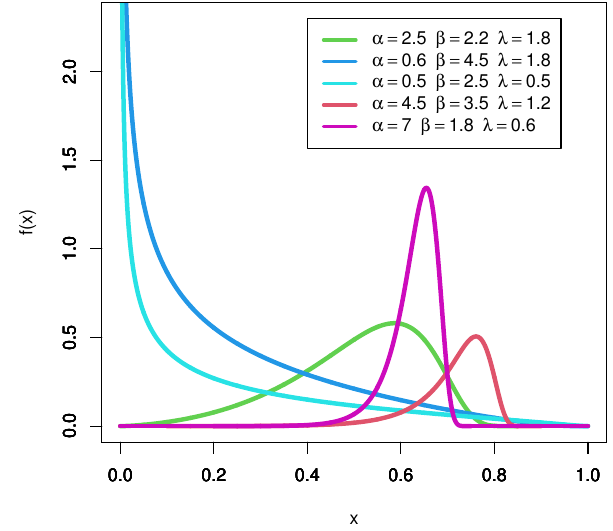
Figure 1. pdf plots of UEPD.